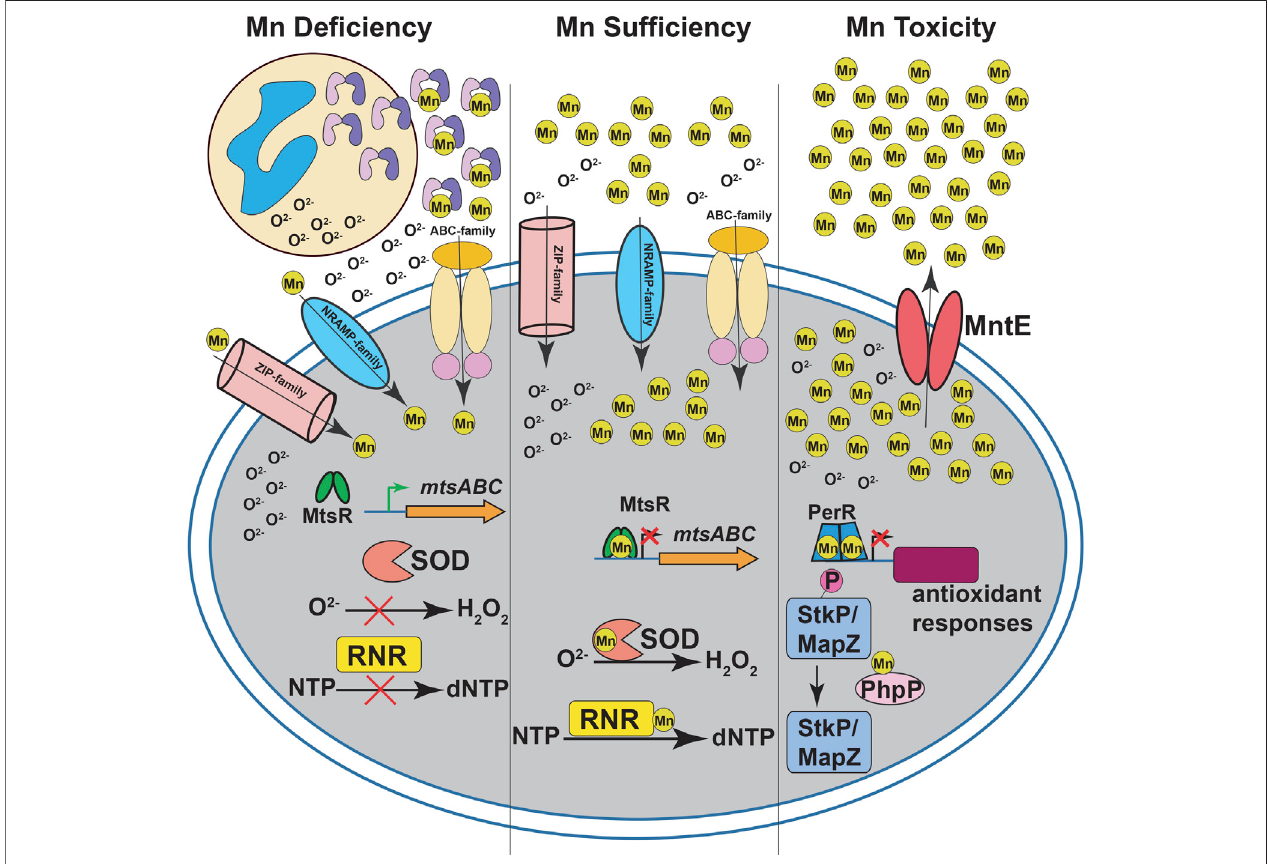
FIGURE 1 | Manganese (Mn) homeostasis during streptococcal infections. During infection, neutrophils release calprotectin (CP) at infection sites (left panel). CP sequesters Mn from the invading pathogen to inhibit streptococcal growth. The intracellular Mn de fi ciency impairs the activity of Mn-dependent superoxide dismutases (SOD) and ribonucleotide reductases (RNR), which leads to defective antioxidant defenses against superoxide (O 2 − ) and de novo DNA synthesis, respectively. The CP- imposedMnde fi ciencyissensedbyMn-sensingmetalloregulator,MtsR,andtheMn-freeMtsRrelievestherepressionofABCfamilyMnimporter mtsABC .TheMn uptake during nutrient-limiting growth conditions in streptococci is mediated primarily by ABC transporters. In some streptococcal species, secondary transporters belonging to NRAMP- and ZIP-family transporters are also involved in Mn acquisition. During Mn suf fi ciency (middle panel), MtsR binds to Mn, interacts with promoters, and represses the expression of target genes including mtsABC . The optimal Mn levels in the cytosol promotes the activity of SOD and RNR. During Mn toxicity (right panel), the Mn ef fl ux pump MntE detoxi fi es bacterial cytosol of excess Mn and promotes streptococcal survival. In the absence of MntE, high cytosolic Mn levels lead to mismetallation of peroxide sensing regulator (PerR) with Mn and results in defective antioxidant responses. Furthermore, Mn mismetallated PhpP phosphatase dephosphorylates cell division kinases StkP and MapZ, which causes improper cell division and altered bacterial cell morphologies.